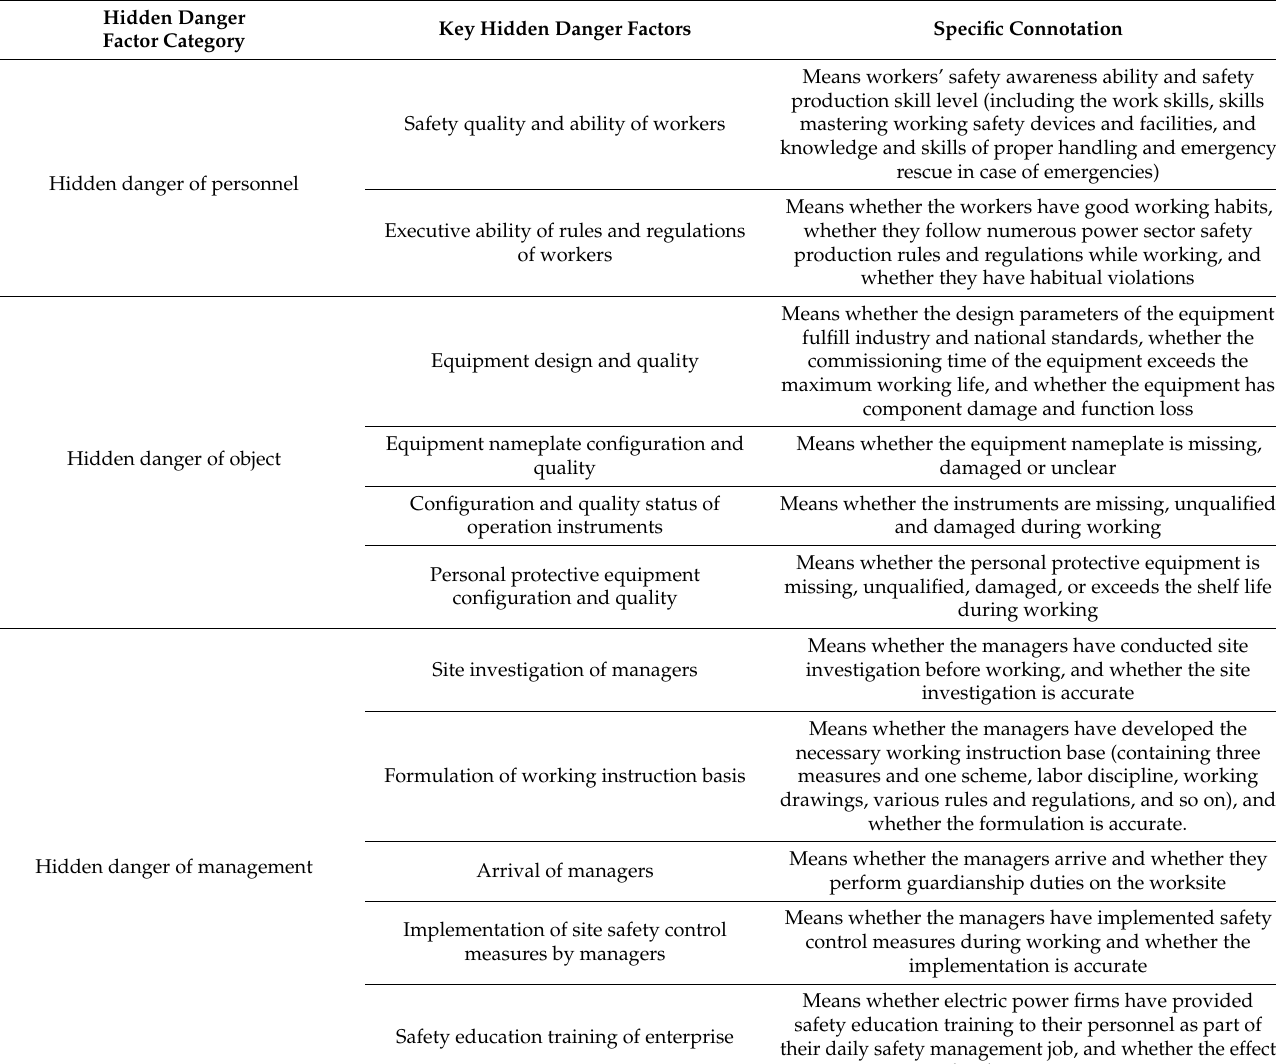
Table 4. Key Hidden Danger Factor System of Electric Power Personal Casualty